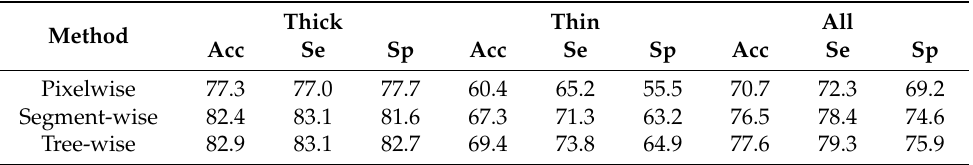
Table 3. Performances of the proposed AV classification method on thick and thin vessels for the IOSTAR dataset. The boundary for the thick and thin vessels is a width of three pixels. The performances of the pixelwise prediction and using a segment-wise voting are also presented for